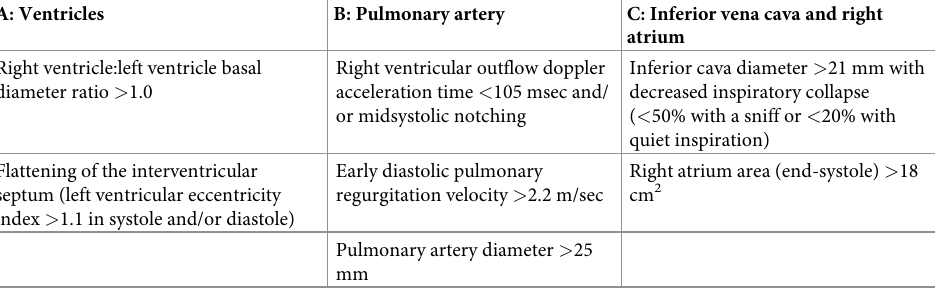
atrium Right ventricular outflow doppler Inferior cava diameter > 21 mm with acceleration time < 105 msec and/ decreased inspiratory collapse or midsystolic notching ( < 50% with a sniff or < 20% with quiet inspiration) Early diastolic pulmonary Right atrium area (end-systole) > 18 regurgitation velocity > 2.2 m/sec cm 2